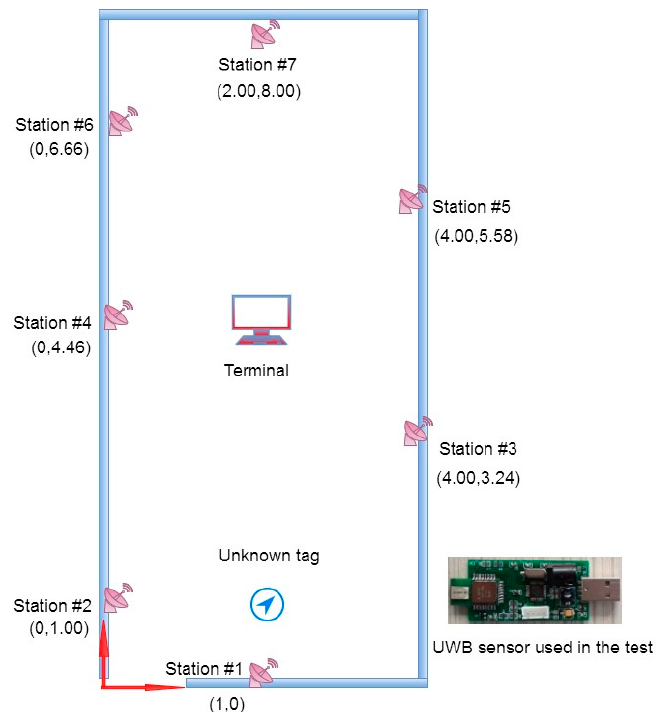
Figure 11. The experimental design.